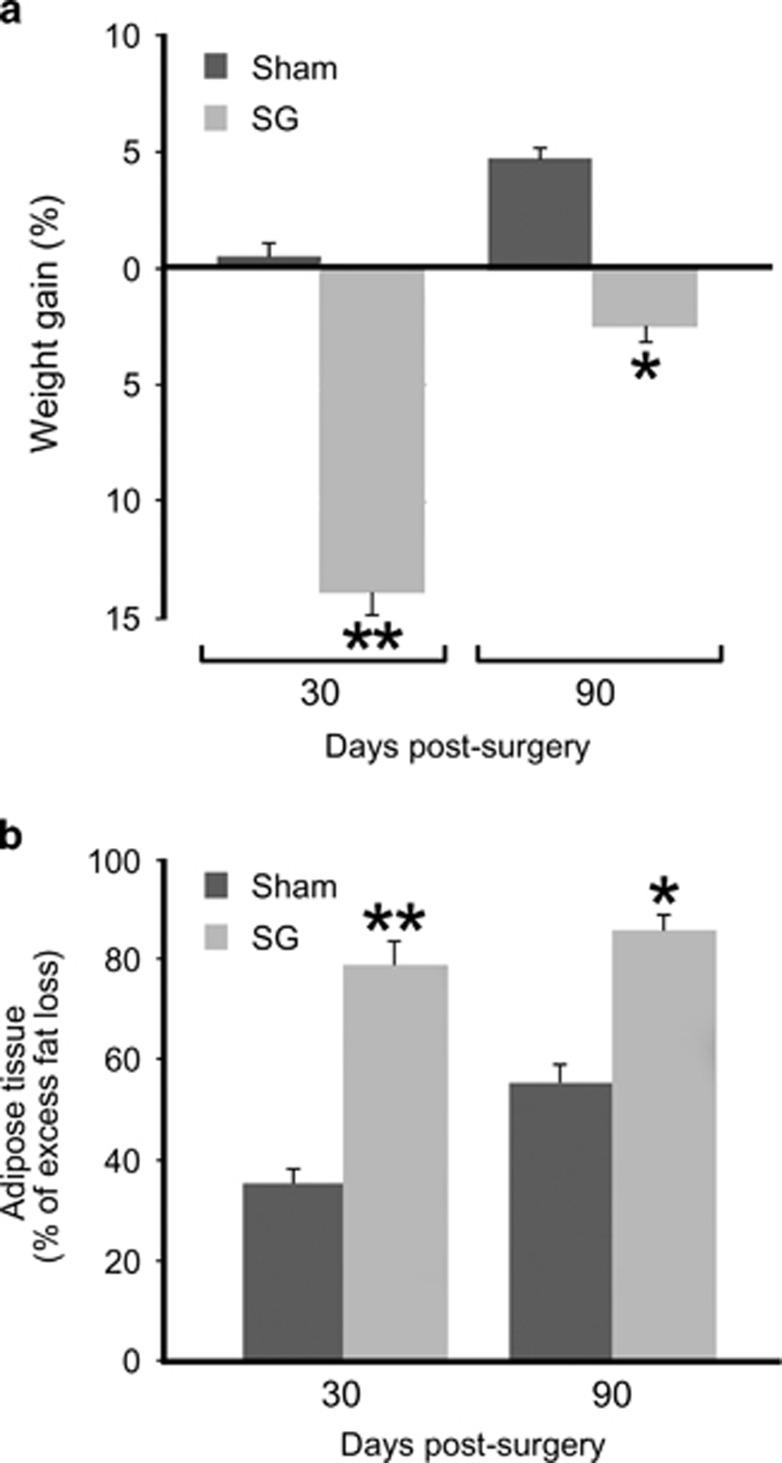
Body weight and fat mass reductions following sleeve gastrectomy (SG). (a) The plot shows gains in body weight at 30 or 90 days after the operations (sham or SG), and the concomitant switch from HFD to normal diet. The weight differences are expressed as a percentage of the change from the respective obese weight, at the time of surgery for each animal group, (x axis). (b) The loss in adipose tissue of the killed animals is expressed as a percentage of the excess fat mass gained during the period of HFD for each group: SG animals lost >80% of the fat mass they gained during HFD, whereas in the sham-operation group the loss of excess fat mass was only 50%. *P< 0.05 and **P< 0.01, asterisks indicate significant differences of body weight between sham- and SG-operated animals in (a) and adipose tissue in (b) at 30 & 90 days post surgery. n=4–6 animals per group.